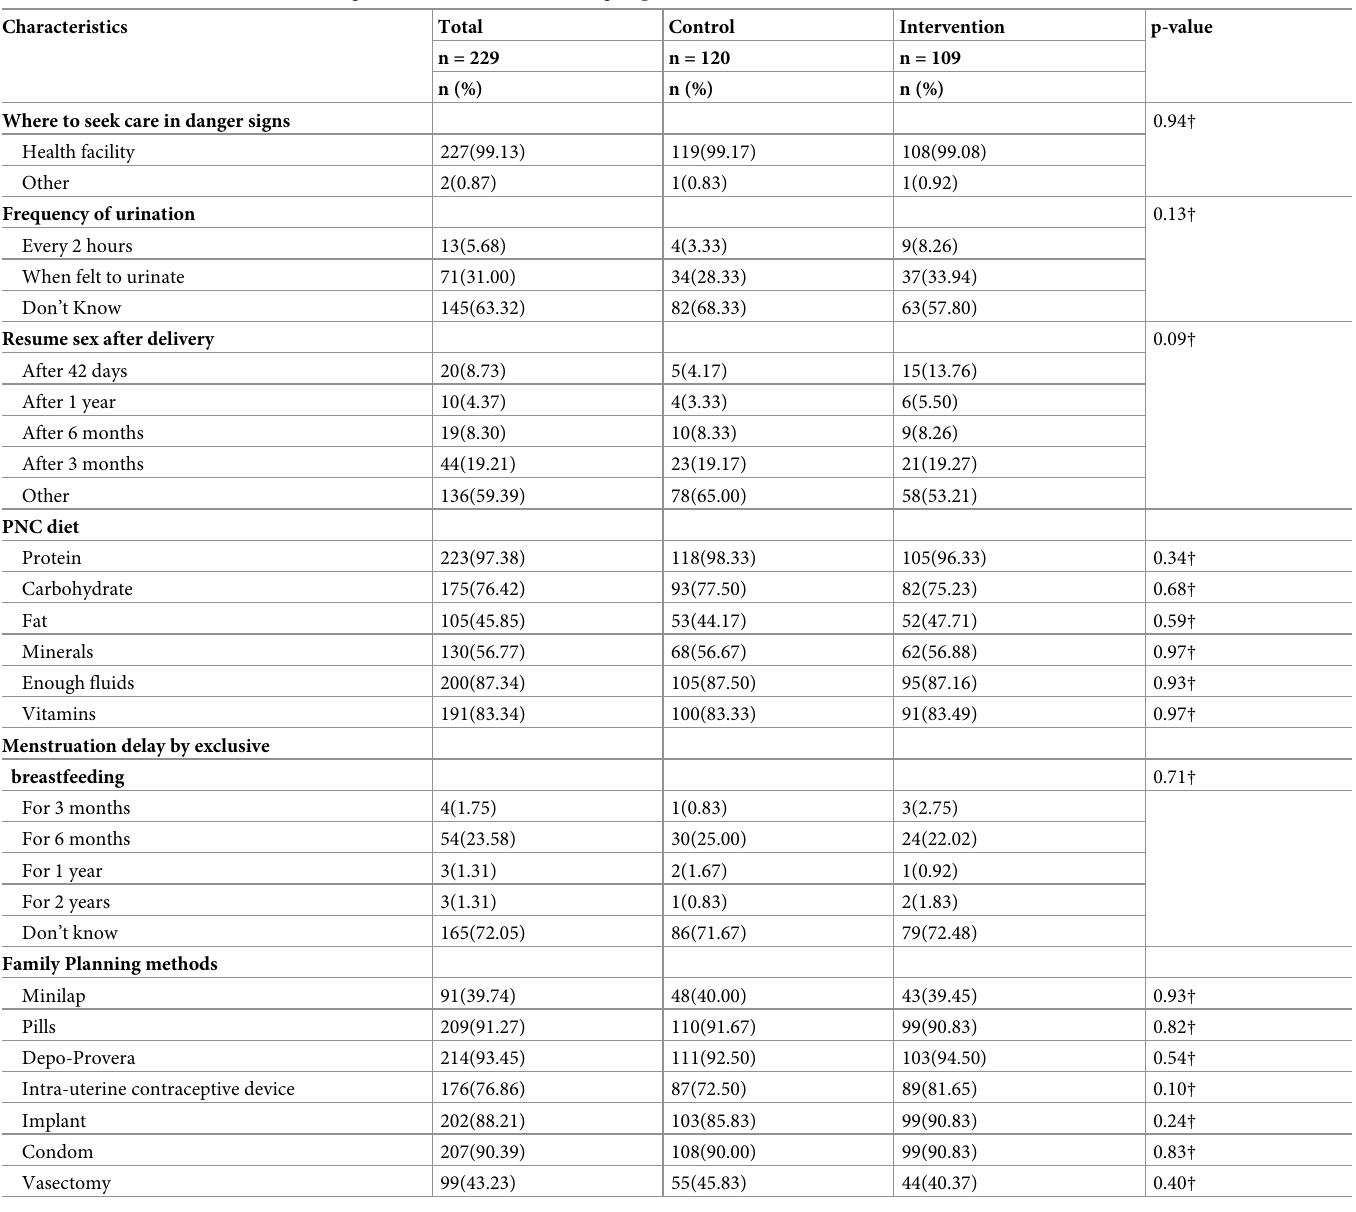
Table 6. Maternal care attributes knowledge of intervention and control group at baseline, n = 229.